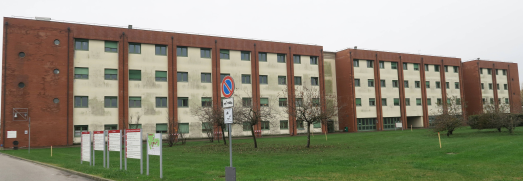
Figure 1. University building fac¸ade considered in this work.